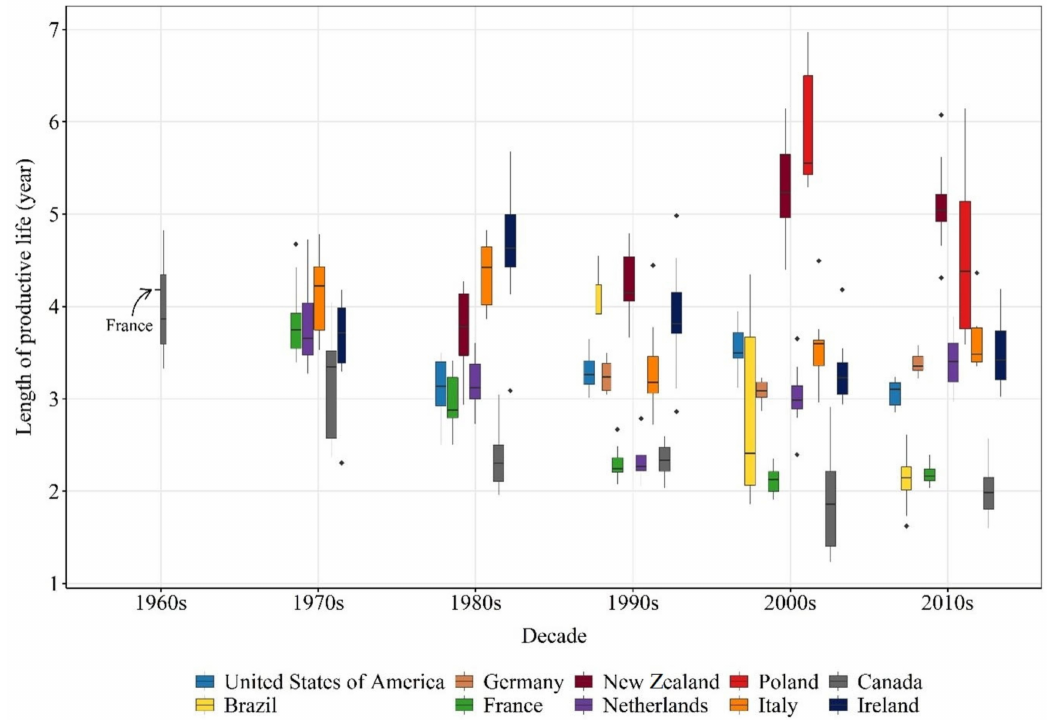
Figure 5. The length of productive life (year) of dairy cows from the top 10 high milk-producing countries on different decades. The relative width of each box per country within decades represents the number of observations available to generate it. The wider the box, the more observations were available. The list of countries is limited to the world’s top high milk-producing countries for which we were able to provide sufficient and reliable data on the length of productive life. Full circles ( • ) represent values above or bellow the interquartile range. Data sources are provided in Table